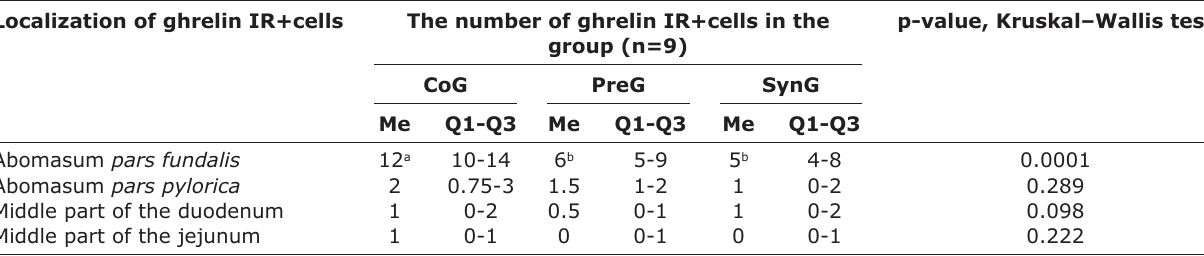
Table-2: Number of ghrelin-IR-positive cells in the abomasum and intestine of 1 mm 2 in calves after 56 days of feeding Jerusalem artichoke flour concentrate and its synbiotic with yeast Saccharomyces cerevisiae . Localization of ghrelin